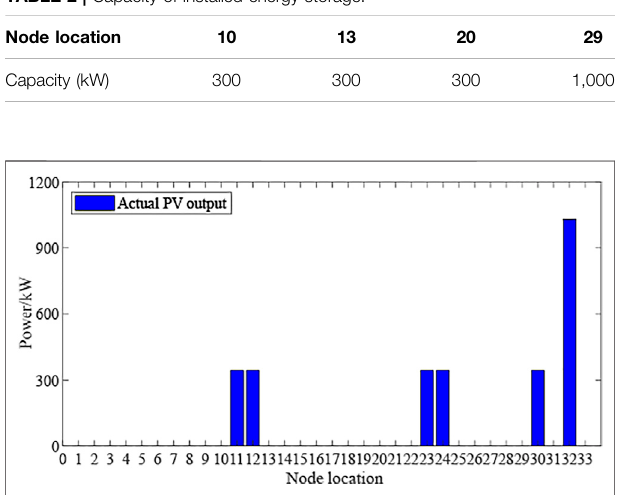
TABLE 2 | Capacity of installed energy storage.